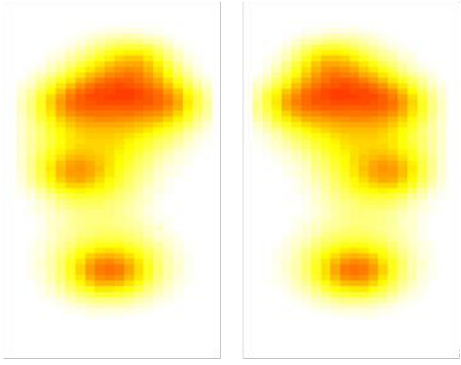
Figure 16. Temperature Map during the stance position.